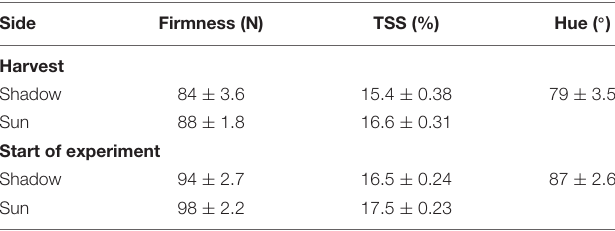
TABLE 1 | Average firmness, total soluble solids (TSS) content and hue of the batch of “Jonagored” apples at harvest (26 September 2016) and the start of the experiment (12 January